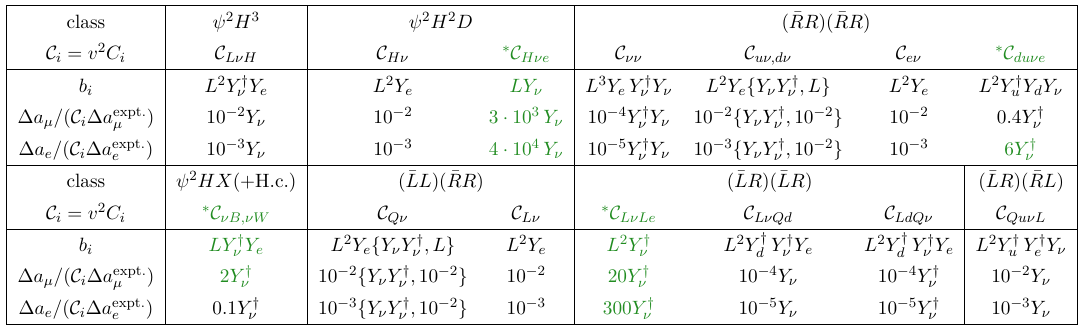
Table 2 . Estimates of the contributions of the dimension-six Wilson coefficients to the coefficients b i (defined in eq. (3.3)), where ∆ a ‘ = (4 m ‘ /v ) b i C i . The third (fourth) row is the ratio ∆ a ‘ / ∆ a expt . for ‘ = µ ( e ) in units of C i = v 2 C i . L stands for a loop factor and Y i are the different Yukawa couplings. The cases with c i , c 0 ≥ 1 are highlighted (in green) with an asterisk. i EFT below the EW scale, ∆ a is generated at tree-level for lepton e by the leptonic dipole ‘